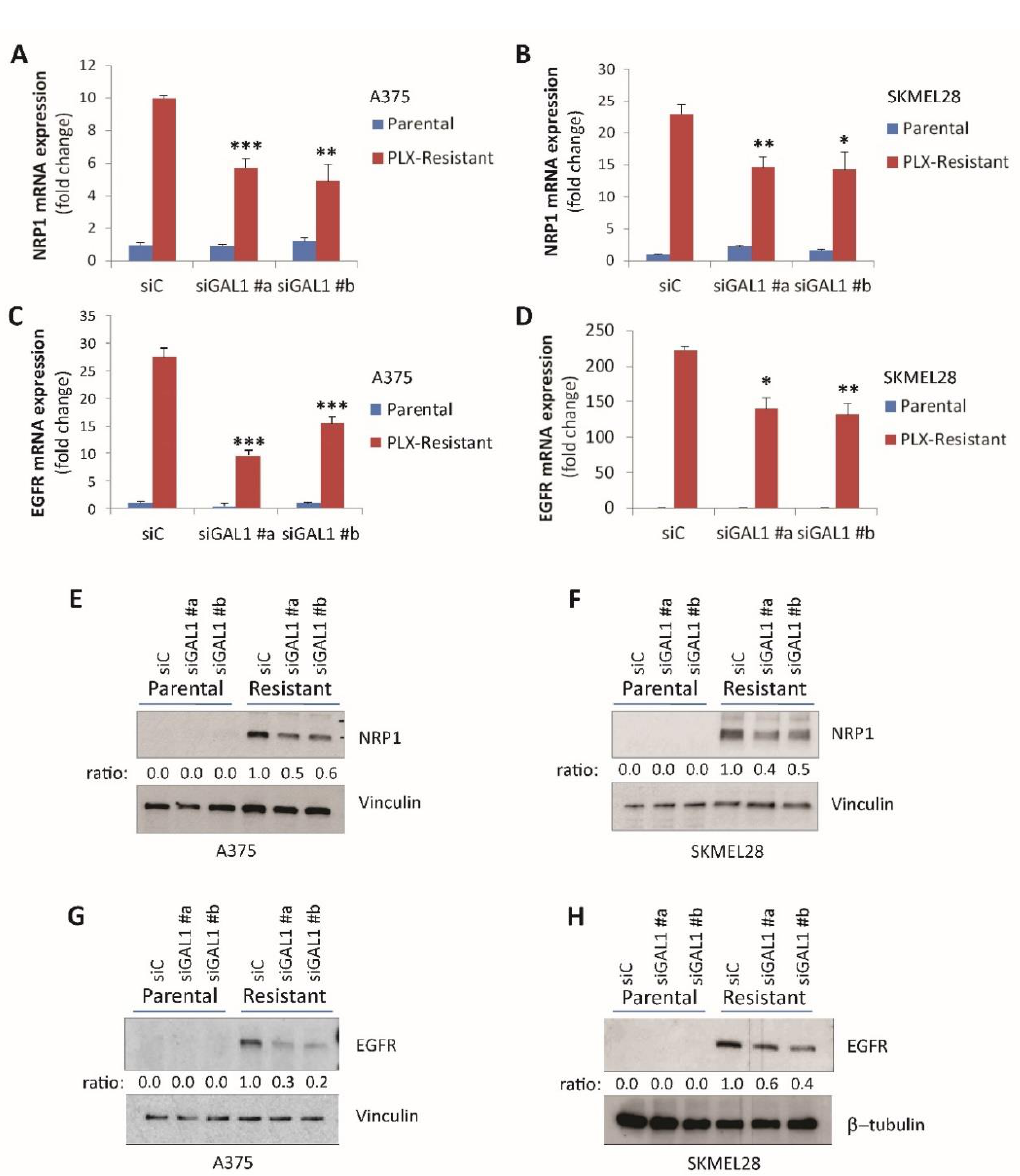
Figure 3. Gal-1 silencing downregulates NRP1 and EGFR expression. ( A , B ) The qPCR analysis of NRP1 expression in parental and PLX-4720-resistant A375 cells (A) and SK-MEL-28 (B) cells subjected to Gal-1 silencing by two different siRNAs (as in Figure 2; averaged values (±SD) were normalized to respective siC-transfected cells). Statistical significance was assessed by t -test by comparison with respective siC-treated conditions: * p < 0.01; ** p < 0.005; *** p < 0.0001. ( C , D ) The qPCR analysis of EGFR expression in the same parental and PLX-4720-resistant A375 and SK-MEL-28 cells subjected to GAL1 silencing analyzed in the previous panels (values normalized to respective siC-transfected cells). Statistical significance was assessed by t -test by comparison with respective siC-treated conditions: * p < 0.01; ** p < 0.005; *** p < 0.0001. ( E , F ) NRP1 expression was assessed by immunoblotting in the same cells subjected to GAL1 silencing analyzed in the previous panels; vinculin provided protein loading controls. The band intensity ratio was calculated and normalized to siC-resistant cells (results from an experiment representative of at least three repetitions). ( G , H ) EGFR expression was assessed by immunoblotting in the same cells analyzed above; vinculin or β -tubulin provided protein loading controls. The band intensity ratio was calculated and normalized to siC-resistant cells (results from an experiment are representative of at least three repetitions).